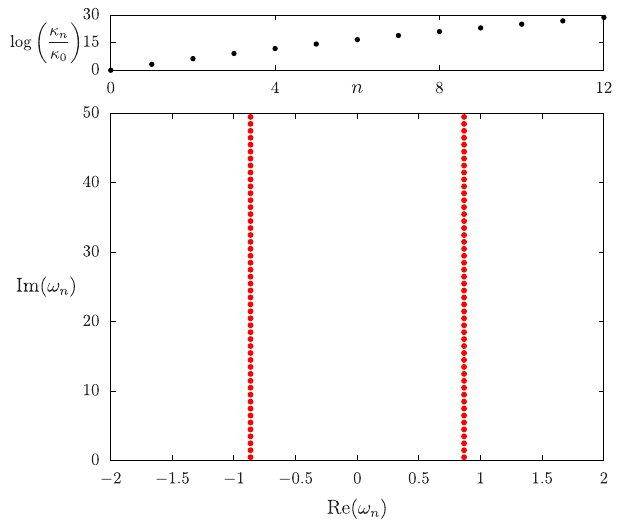
FIG. 3. Pöschl-Teller QNM problem. Bottom panel: QNM spectrum for the Pöschl-Teller potential, calculated in the hyper- boloidal approach described in Sec. VA, with Chebyshev spectral methods and enhanced machine precision. Top panel: ratios of condition numbers κ of the first QNMs over the condition n number κ 0 of the fundamental QNM, indicating a growing spectral instability compatible with the need for using enhanced machine